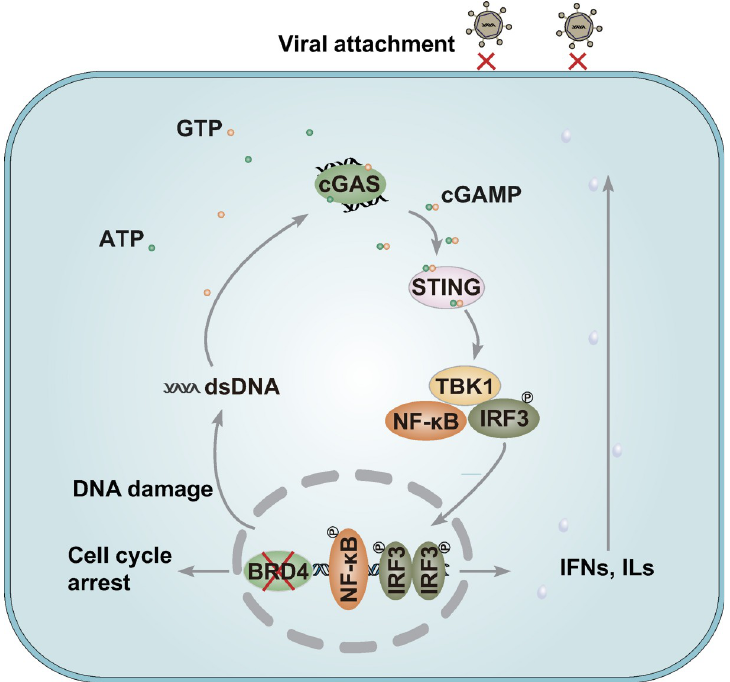
Fig 10. A schematic model showing BRD4 inhibition in antiviral innate immunity. BRD4 inhibition leads to DDR- induced activation of cGAS-mediated innate immune pathway, which exhibits broadly antiviral activity through impairment of viral